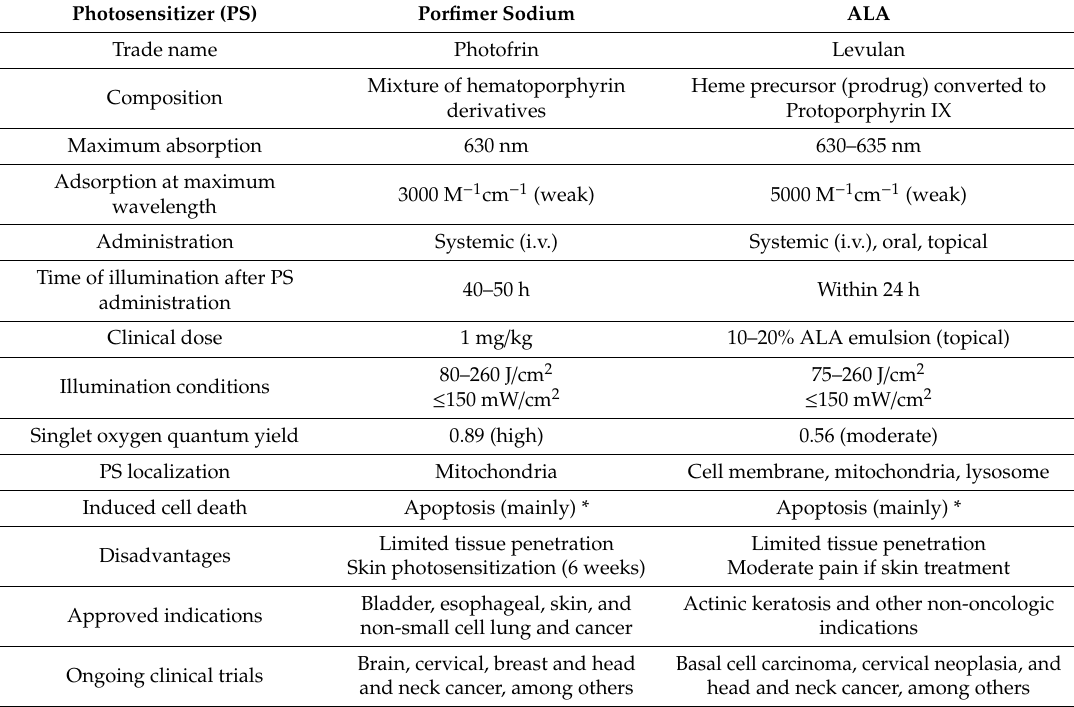
Table 1. Principal characteristics of the photosensitizers Photofrin and